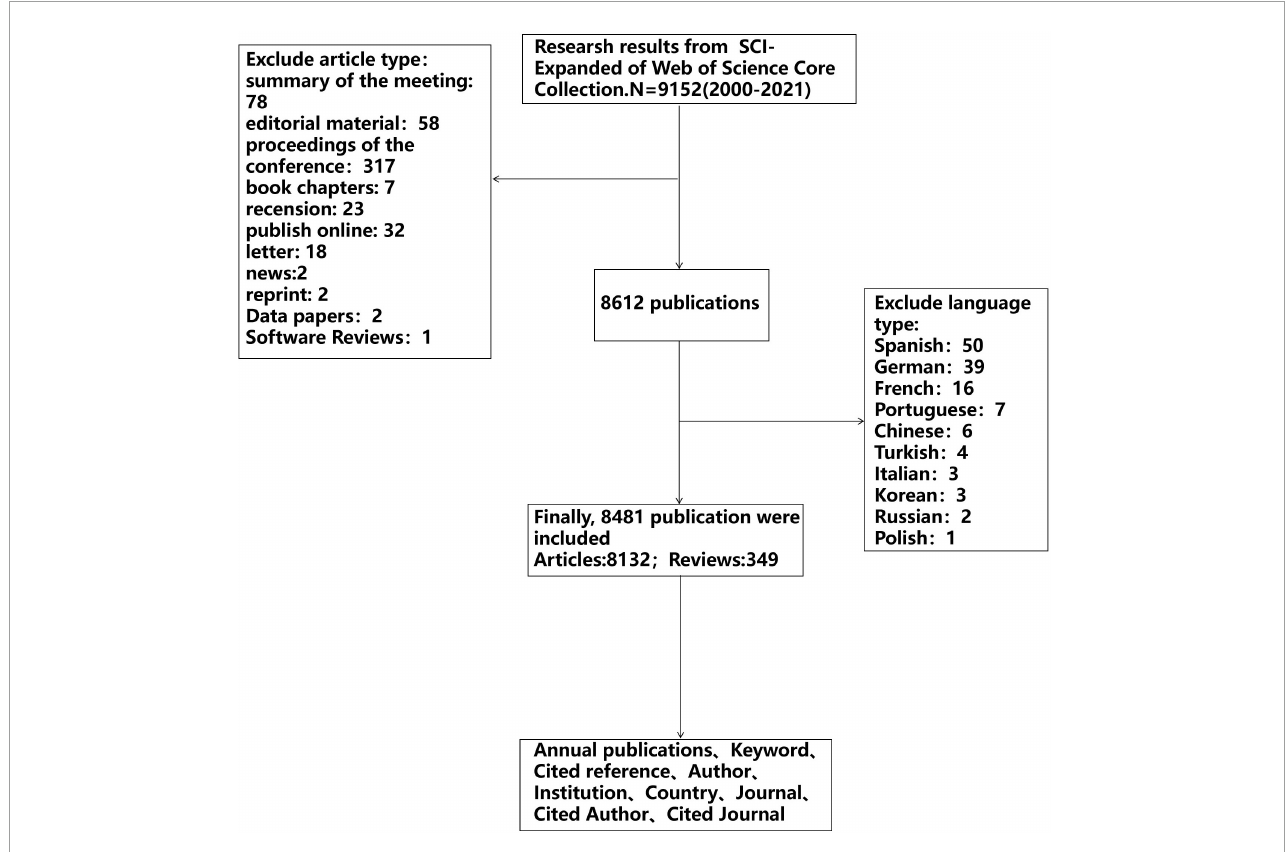
FIGURE1 Flowchart of the retrieval strategy in the